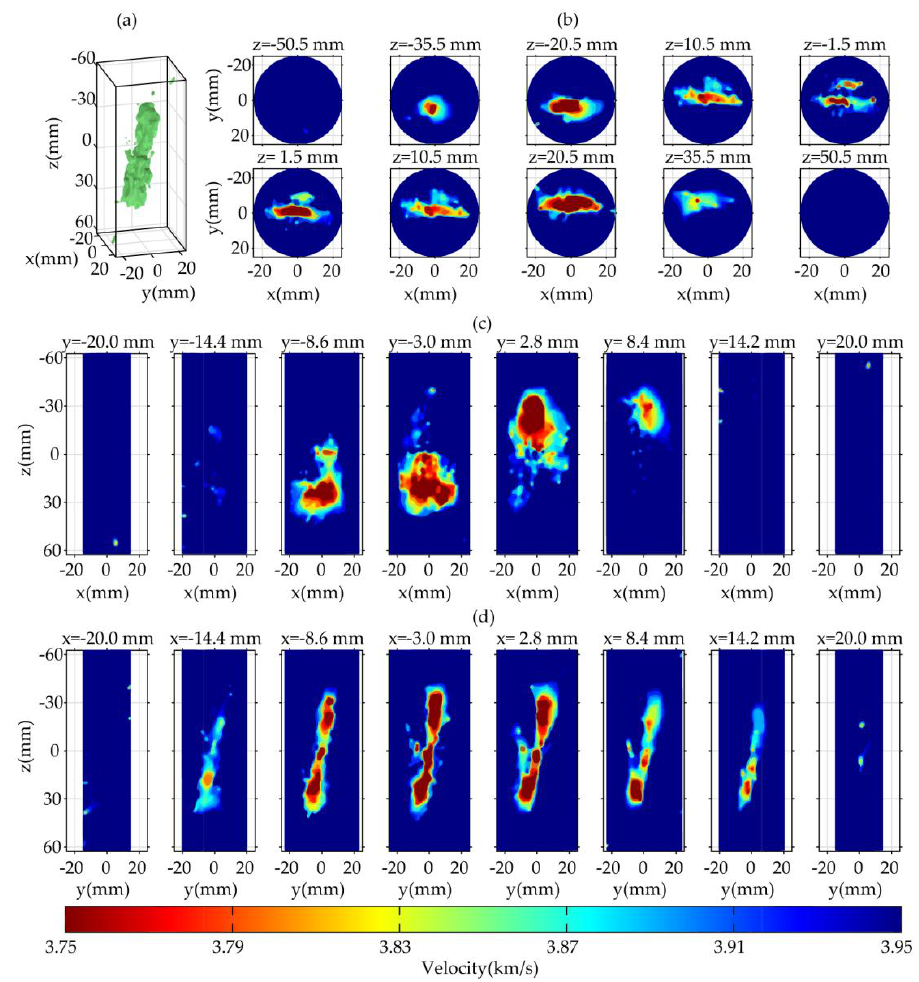
Figure 13. Tomographic images of TVR under sparse ray-coverage. ( a ) the 3D segmented image; ( b ) the transverse-view profile; ( c ) the coronal-view profile; and ( d ) the sagittal-view profile. The caption of each sub-image in ( b – d ) represents the profile position.